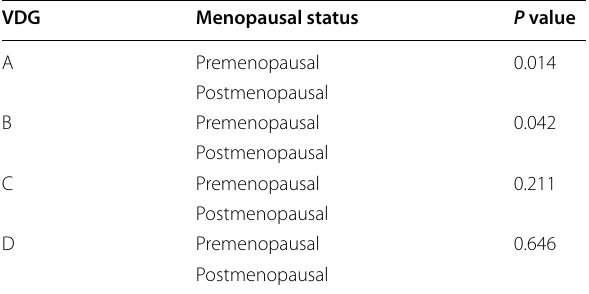
Table 3 Difference in distribution of different volumetric